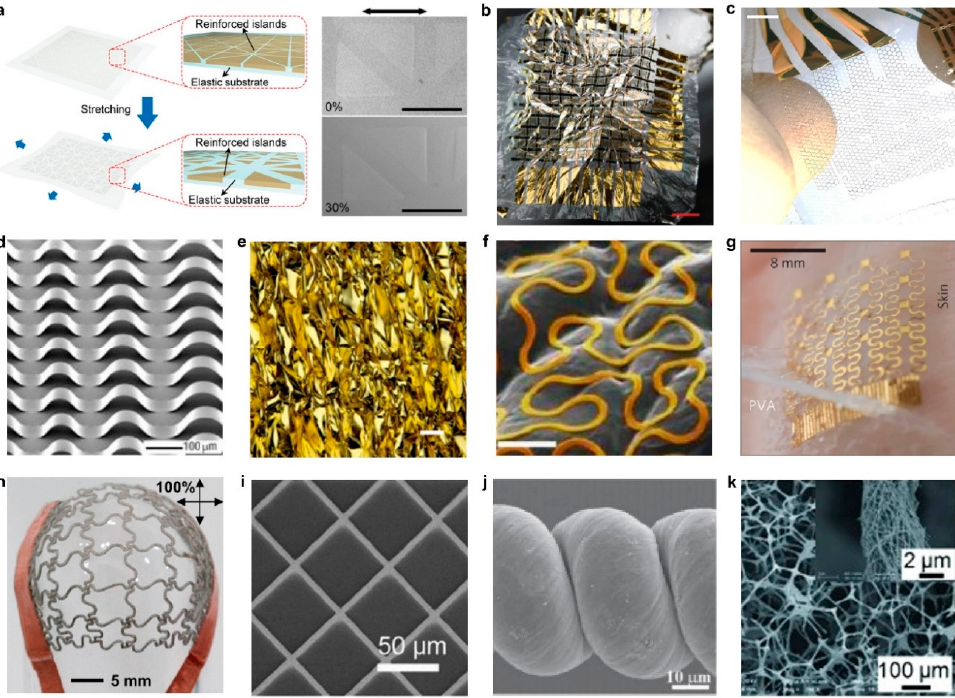
Figure 3. ( a ) (Left) Schematic image of the hybrid substrate where the reinforced islands are embedded in the elastic substrate. (Right) SEM images before (top) and during (bottom) 30% stretching. The arrow indicates the direction of stretching direction. Scale bars, 500 µ m. (reprinted with permission from [15]. Copyright 2018 American Association for the Advancement of Science); ( b ) at only 2 µ m thickness, devices are ultraflexible and can be crumpled like a sheet of paper. Scale bar, 1cm (reprinted with permission from [72]. Copyright 2013 Nature Publishing Group); ( c ) A 4 × 4 stretchable organic electrochemical transistors (OECT) array when intrinsically stretched. Scale bar, 3 mm (reprinted with permission from [73]. Copyright 2018 American Association for the Advancement of Science); ( d ) Si ribbon structures formed on a PDMS substrate pre-strained to 50% and patterned with W act = 15 µ m and W in = 250, 300, and 350 µ m (from left to right). The image was taken by tilting the sample at an angle of 45 ◦ (reprinted with permission from [74]. Copyright 2006 Nature Publishing Group); ( e ) Corresponding optical micrographs of the wrinkled Au film electrode at 0%. Scale bar, 100 µ m (reprinted with permission from [75]. Copyright 2018 American Chemical Society); ( f ) scanning electron microscopy images of third-order Peano-based wires on skin and a skin-replica (colorized metal wires), showing the conformal contact of the wires on the substrate. Scale bar in ( f ), 500 µ m (reprinted with permission from [76]. Copyright 2014 Nature Publishing Group); ( g ) Image of a 4 × 4 TCR sensor array after application to the skin using a water-soluble adhesive tape based on poly(vinyl alcohol) (reprinted with permission from [77]. Copyright 2013 Nature Publishing Group); ( h ) Optical image of a final mesh heater after biaxial stretching up to ~100% (reprinted with permission from [78]. Copyright 2015 American Chemical Society); ( i ) SEM images of Ag mesh, demonstrating a space length